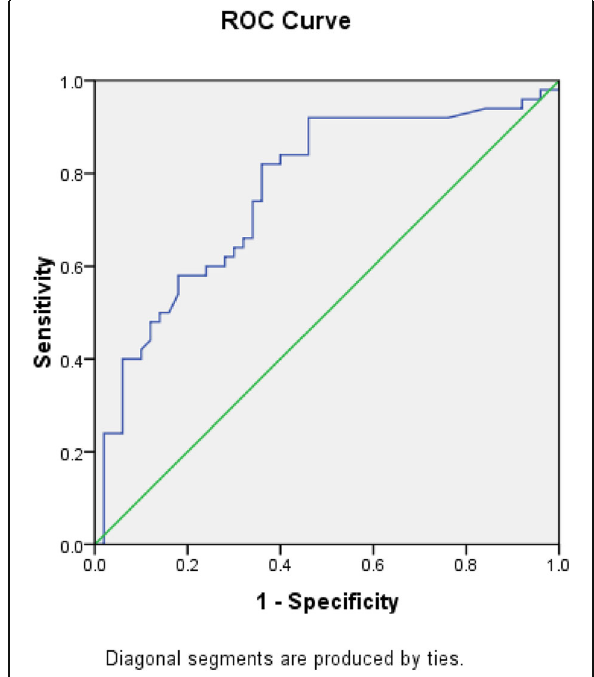
Fig. 1 ROC curve for detection of neurological dysfunction using bilirubin/albumin ratio in all